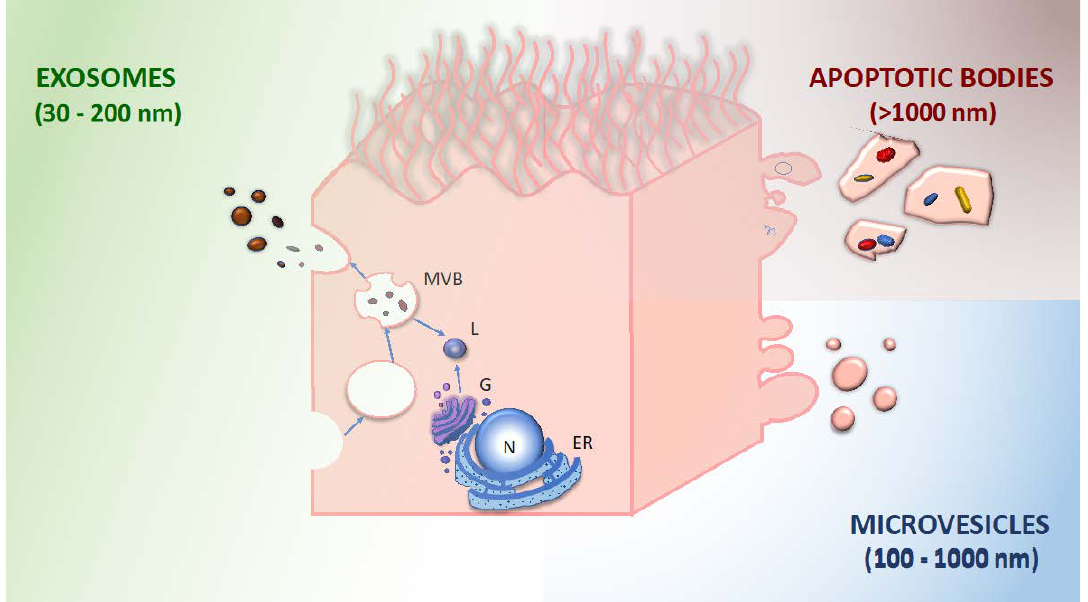
Figure 2. Epithelial cells have the potential to release extracellular vesicles with different sizes, origins, and cargoes. Within the endosomal system, internalized cargoes are sorted into early endosomes that then mature into multivesicular bodies (MVB). Cargoes are also delivered from the trans-Golgi network (G) and from the cytosol. Multivesicular bodies cargoes get transported to the plasma membrane, fuse with the cell surface, and are secreted in the extracellular space as exosomes. At variance, microvesicles refer to vesicles generated via direct outward blebbing and pinching of the plasma membrane, a phenomenon accompanied by distinct, localized changes in plasma membrane protein and lipid components that will result in alteration of the membrane curvature and rigidity. Finally, cells that undergo apoptosis go through membrane blebbing and disintegration of the cellular content, which will produce apoptotic bodies. ER: endoplasmic reticulum; N: nucleus; L: lysosome.